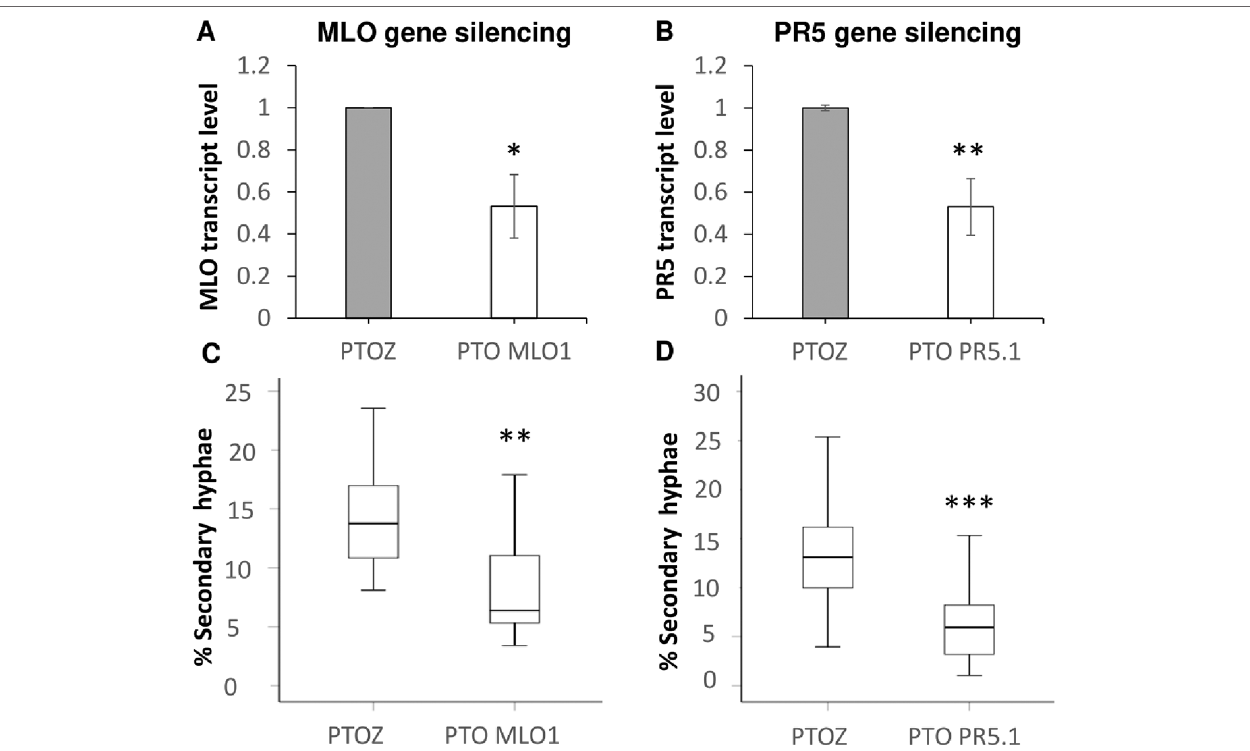
FIGURE 5 | Transient-induced gene silencing (TIGS) of (A) , MLO1 (HORVU4Hr1G082710), and (B) , PR5 isoform TLP5 (KP293850.1/HORVU5HrG005180.6); excised barley leaves were treated with PTO MLO.1 and PTO PR5.1 short antisense phosphorothioate-modified oligodeoxynucleotides for gene-specific silencing. PTOZ was used as negative control (A) . TLP5 relative transcript levels estimated by qRT-PCR using PTOZ negative control for normalization. HvGAPDH was used as reference gene. Average of three ( MLO1 ) and six ( TLP5 ) independent biological replicates each analyzed in three technical replicates are shown. Significance was estimated by one-sample t -test. * indicates P < 0.05; ** indicates P < 0.01; *** indicates P < 0.001. Fungal development was compared between (C) MLO1 - and (D) TLP5 -silenced leaves with and PTOZ-treated control leaves, monitoring the proportion of conidia able to produce secondary hyphae (%SH). N = 19/43 total individual leaves analyzed for each treatment, spanning across four and seven independent biological replicates for MLO1 and TLP5 silencing experiments, respectively. Results are presented as boxplots showing median, interquartile, and minimum/maximum values. Significance was estimated with GLMM. * indicates P < 0.05; ** indicates P < 0.01; *** indicates P < 0.001. qRT-PCR, quantitative reverse transcription polymerase chain reaction; GLMM, generalized linear mixed